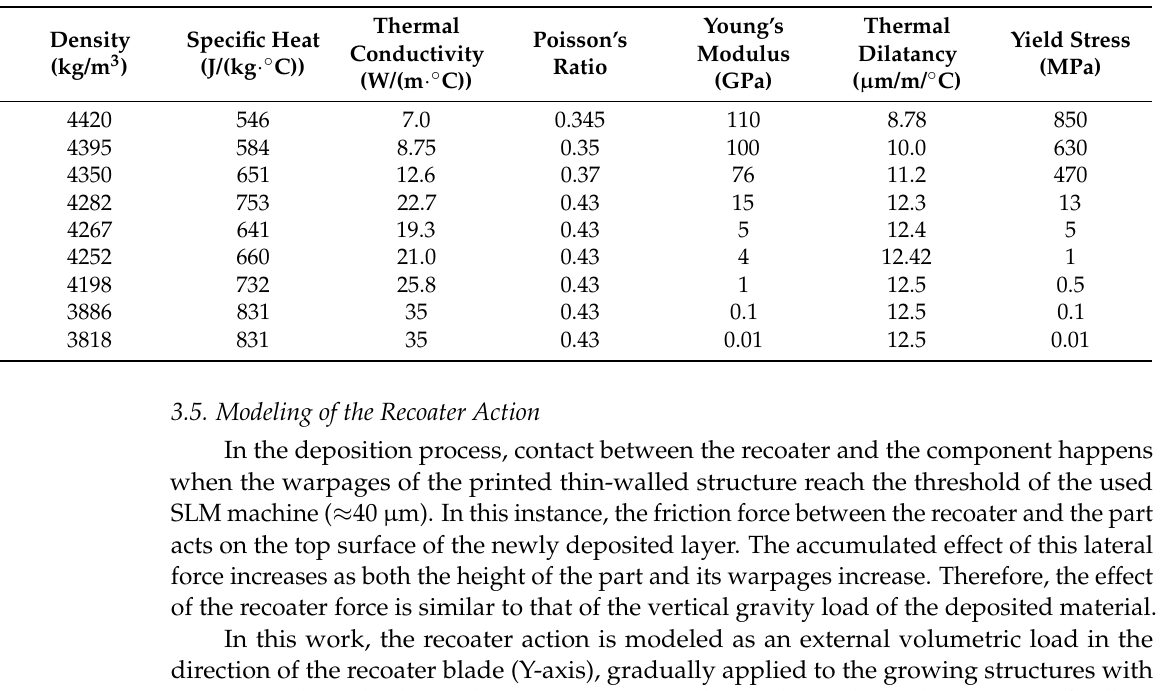
Table 3. Temperature-dependent material properties of